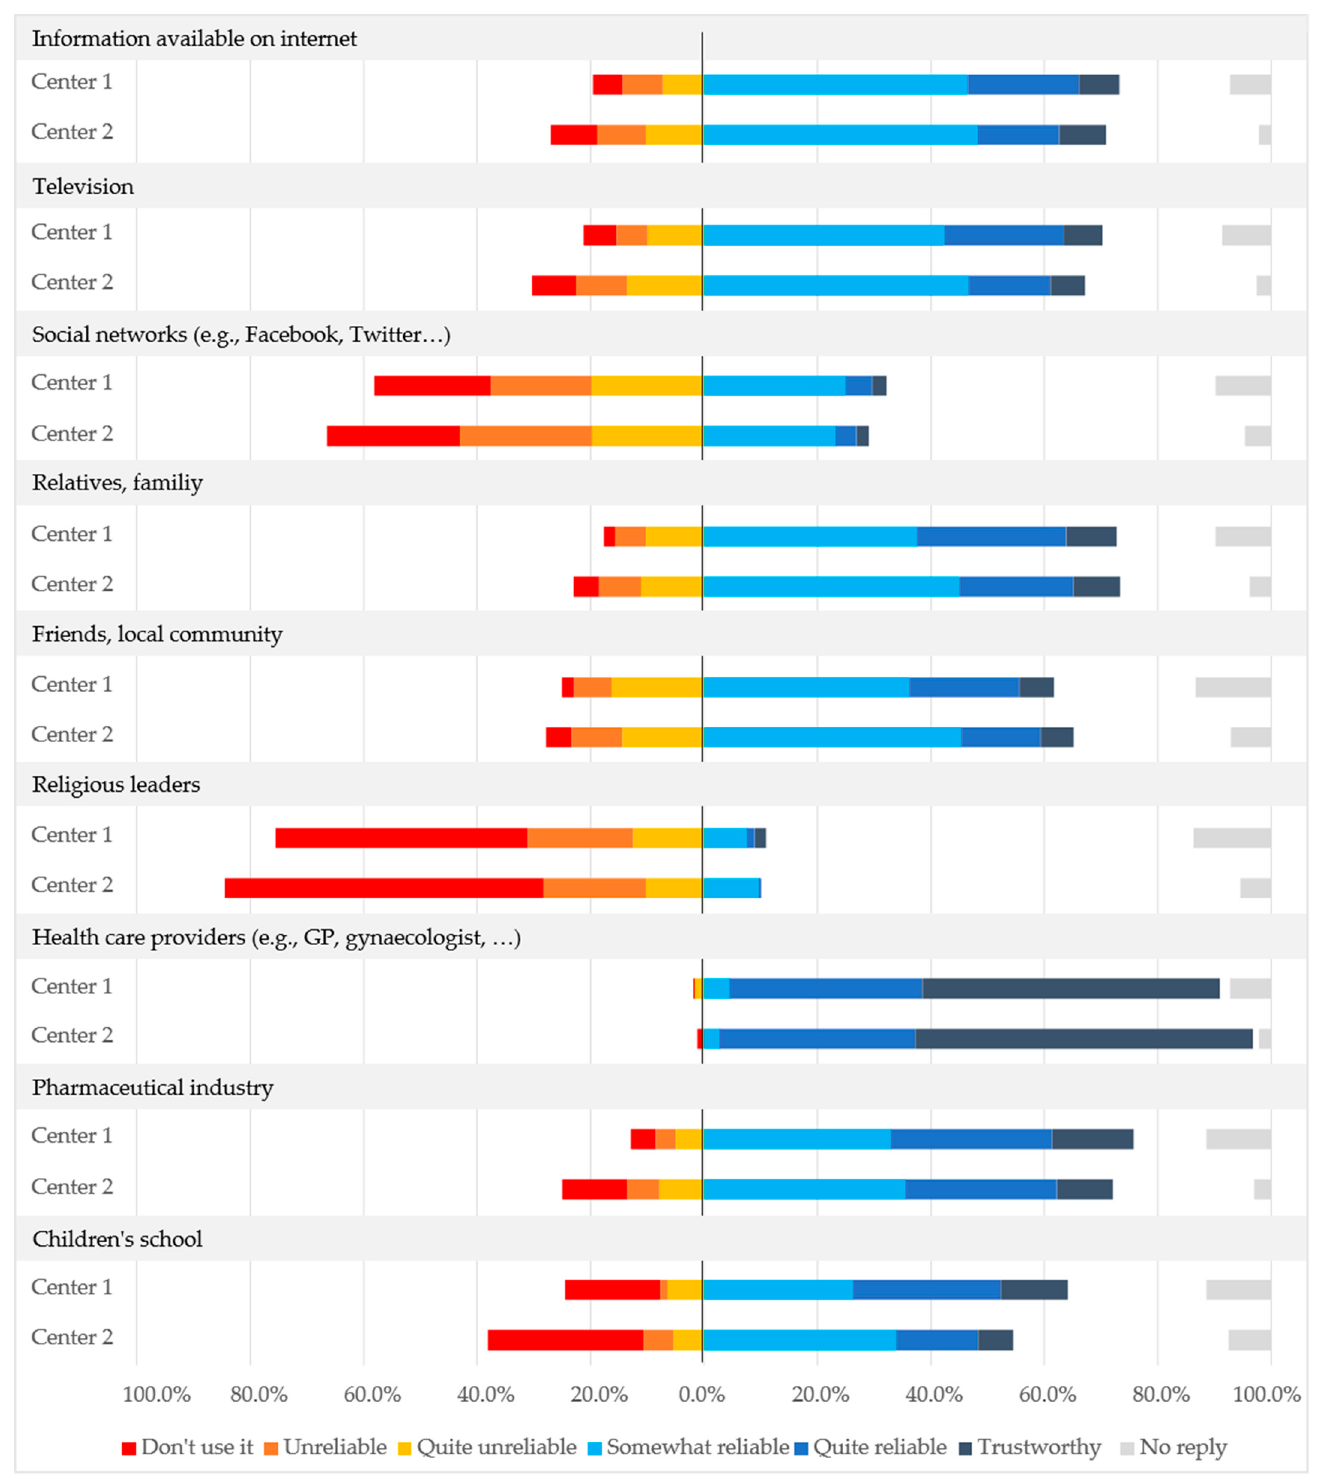
Figure 3. Use of and level of trust in various sources from which participants at Center 1 and Center 2 obtain medical and vaccine information, expressed as a proportion of all participants at each cen- ter.